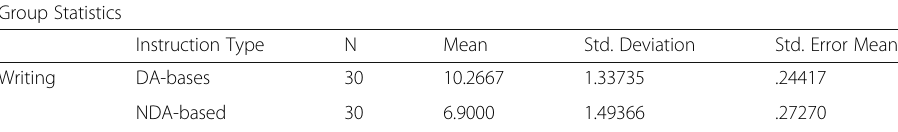
Table 11 Descriptive statistics of the two groups ’ ZAD assessments on the posttests Group Statistics